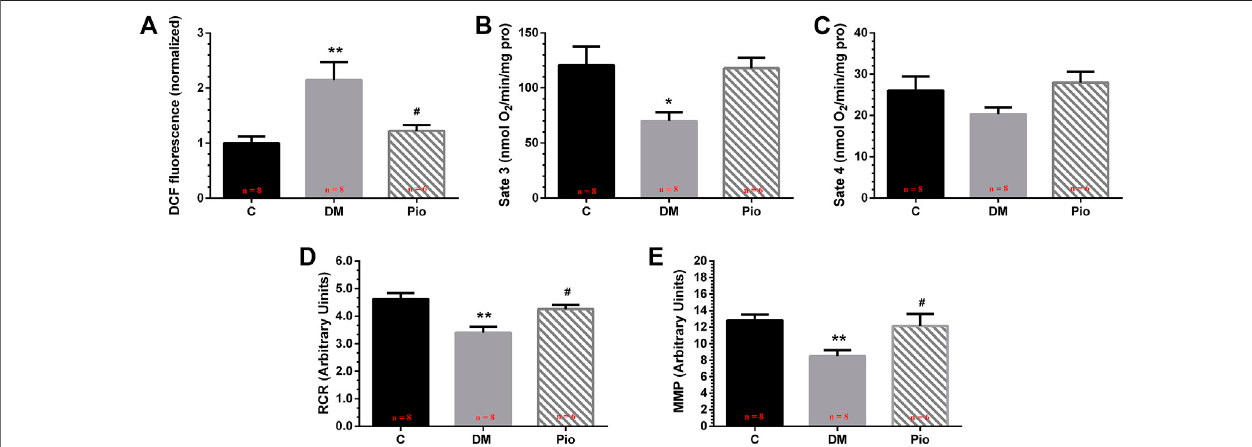
FIGURE4 | Pioglitazone inhibiteddiabetes-induced mitochondrial oxidative stressand dysfunction.Quanti fi cation ofmitochondrial reactiveoxygen species (ROS) levels (A) , state 3 respiration rate (B) , state 4 respiration rate (C) , respiratory control ratio (RCR) (D), and mitochondrial membrane potential (MMP) (E) . Values are presented as mean ± SEM. *Compared with the C group, p < 0.05; **compared with the C group, p < 0.01; #compared with the Diabetic group, p < 0.05. n (cid:2) 6 – 8 per group.